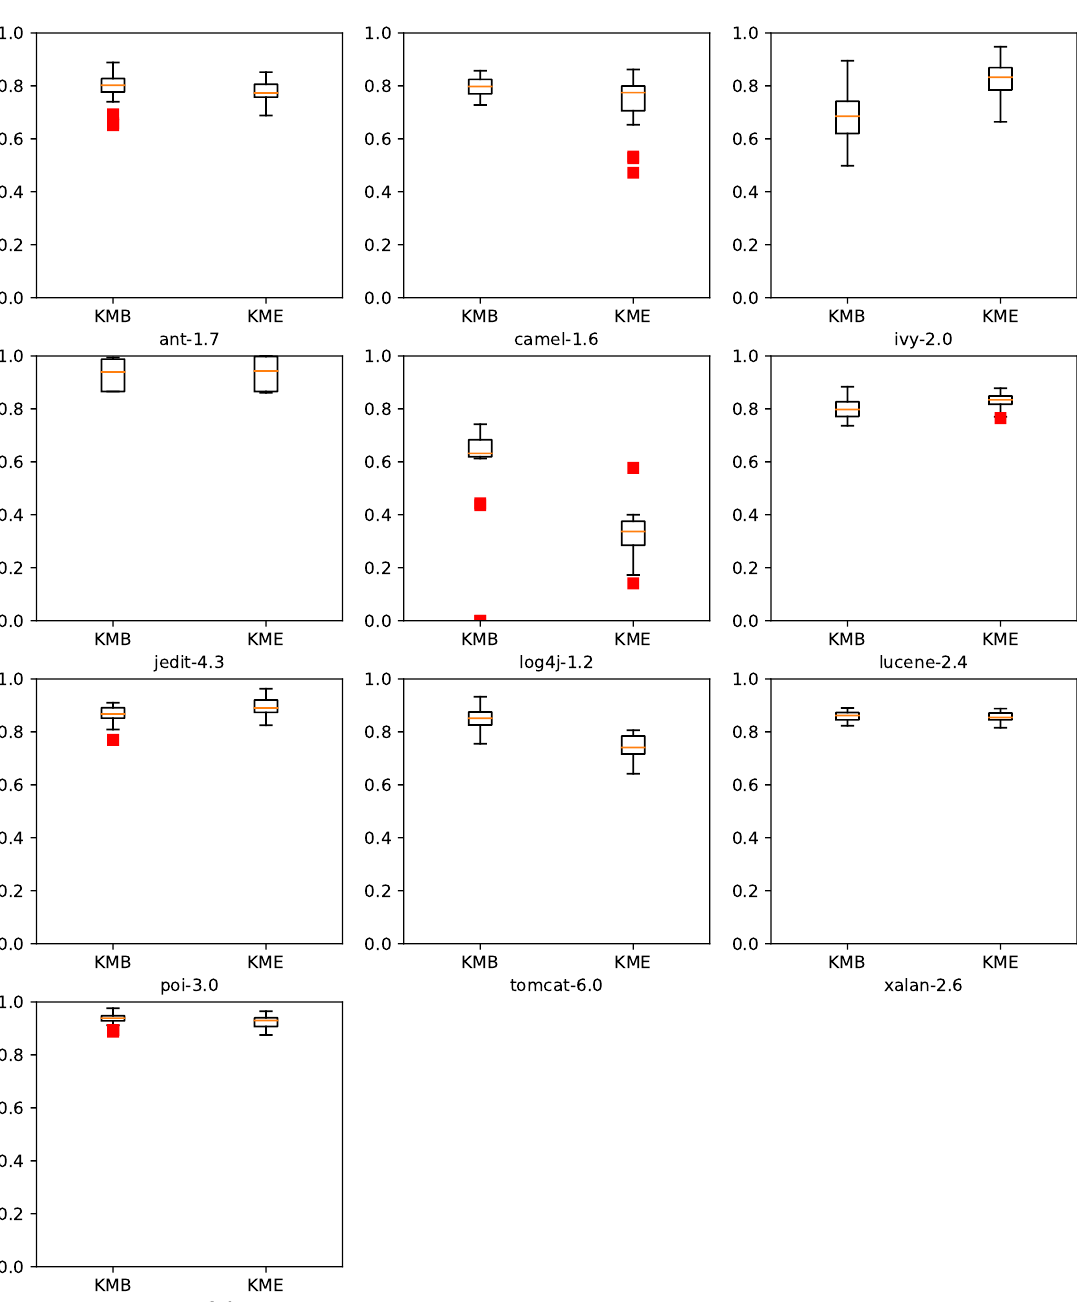
Figure 12. Boxplot representing the G-mean of KMB and KME for PROMISE